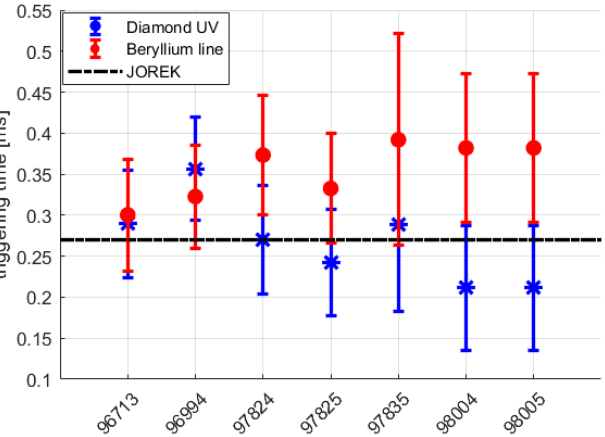
Figure 12. Average triggering time using diamond sensor and beryllium spectroscopy. The black line reports the expected triggering time window with JOREK [17]. As it can be seen, even in different physical scenarios, the estimates are compatible, but the diamond UV detector’s ones have averages more in line with numerical estimates.